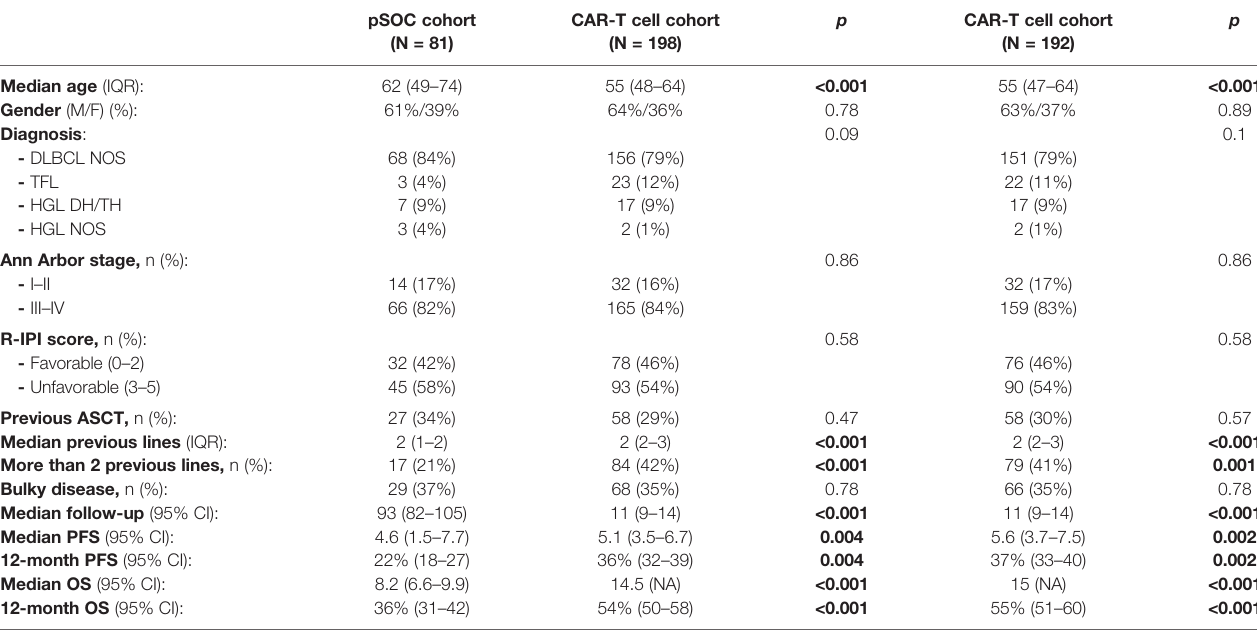
TABLE 1 | Comparison of the previous standard-of-care (pSOC) cohort versus CAR-T cell, intention to treat (ITT), and infused cohorts. pSOC cohort CAR-T cell cohort p CAR-T cell